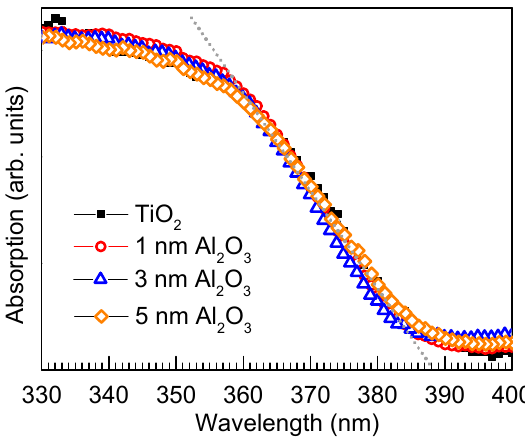
Figure 4. Absorption spectra of pristine anatase TiO 2 powder and the TiO 2 coated with Al 2 O 3 films with different thicknesses: 1 nm, 3 nm, and 5 nm.